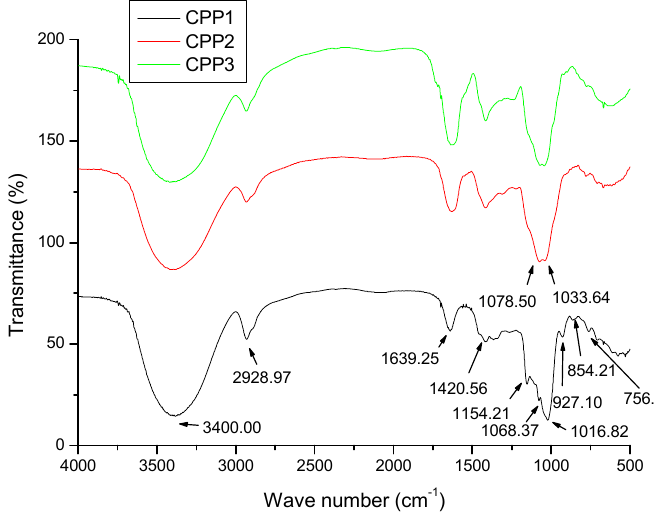
Figure 5. FT-IR spectra of CPP1, CPP2, and CPP3.